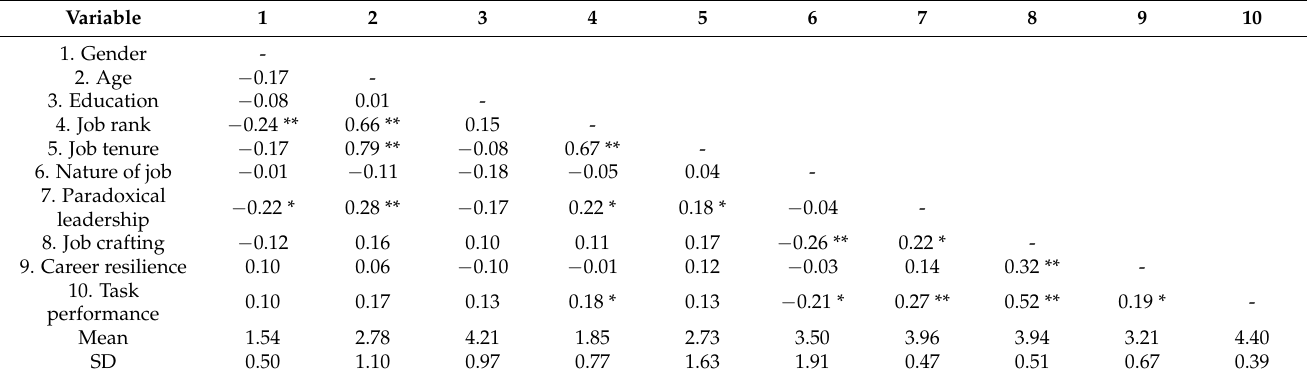
Table 1. Descriptive statistics and correlations.